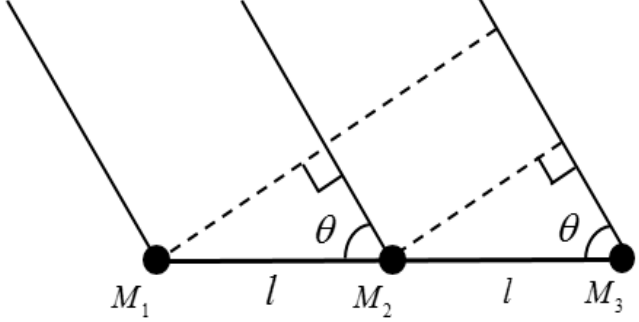
Figure 2. Principle of the angle measurement to the sound source in 2D space.